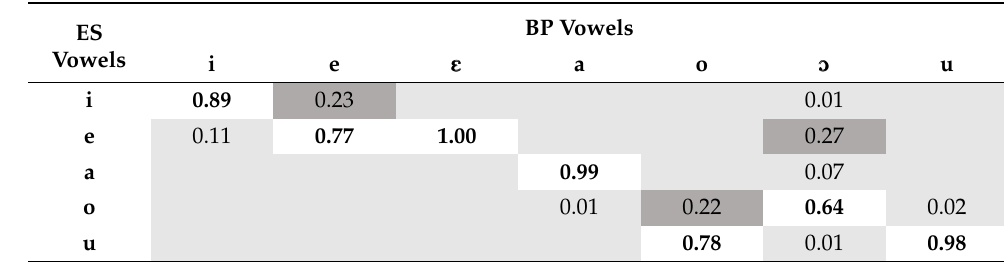
Table 2. Average probability scores of predicted ES vowel group membership for BP male and female tokens tested on the ES model. Probabilities are averaged across the individual discriminant analysis for each speaker. The native vowel category with the highest probability appears in a cell in bold, with no shading, probabilities above chance appear in cells shaded dark grey and probabilities below chance (i.e., 0.20) appear in cells shaded light